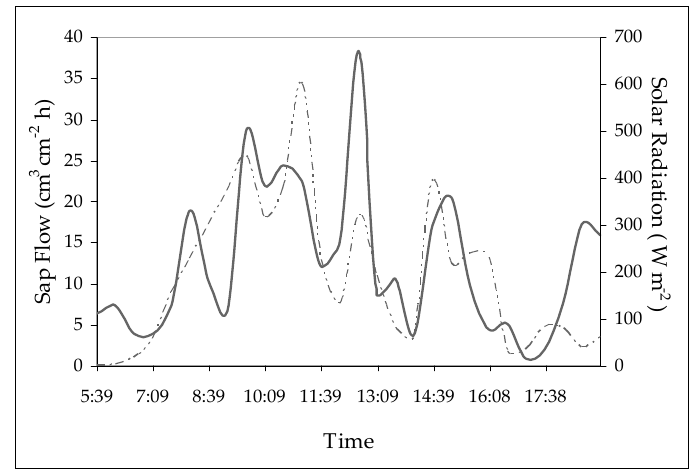
Figure 3. An example of a Lodgepole pine tree diurnal sap flow. Tree’s diameter at breast height was 17 cm. Day of the year: 216, in 2004. Dashed line is R s and the solid line is J i .